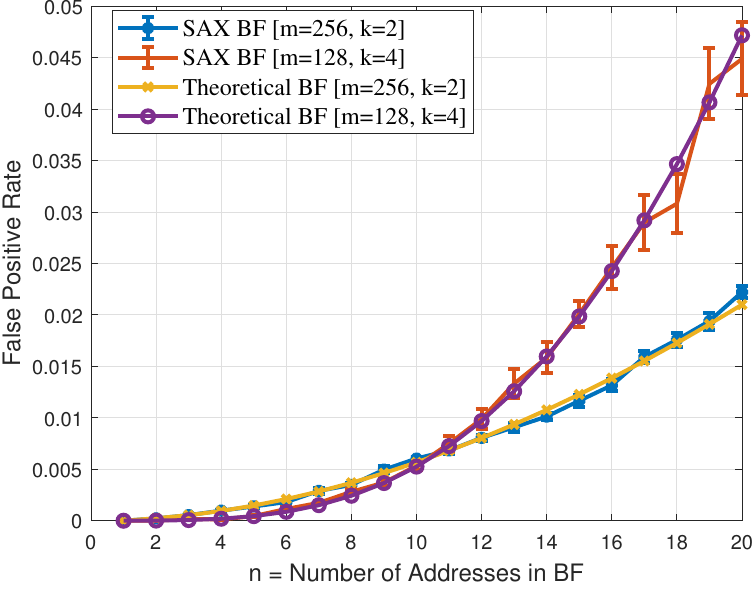
Figure 5. Bloom Filter False Positive Rate